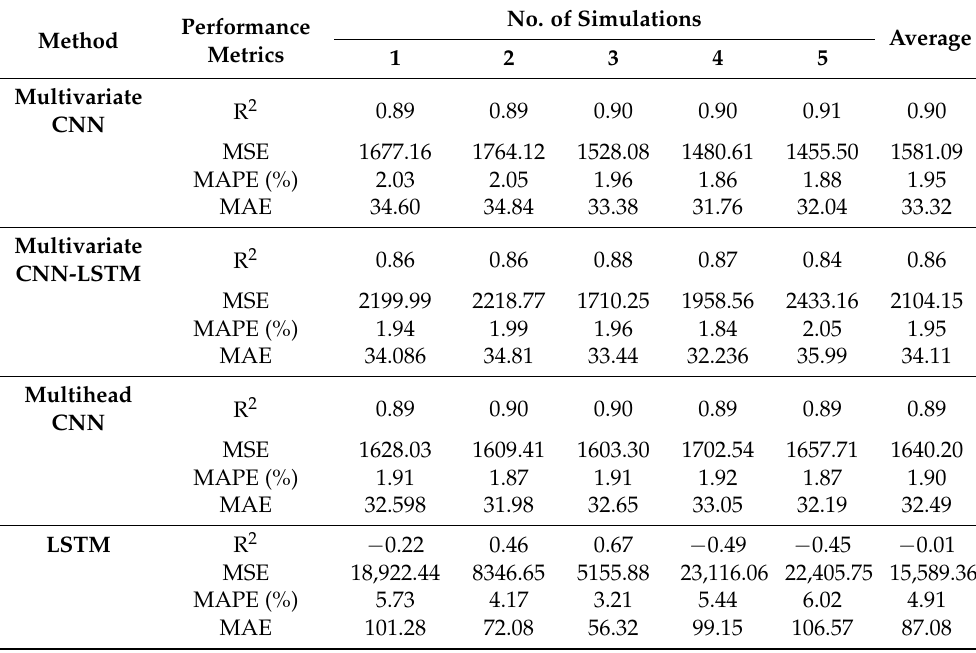
Table 13. Evaluation of CNNs and LSTM robustness against Gaussian